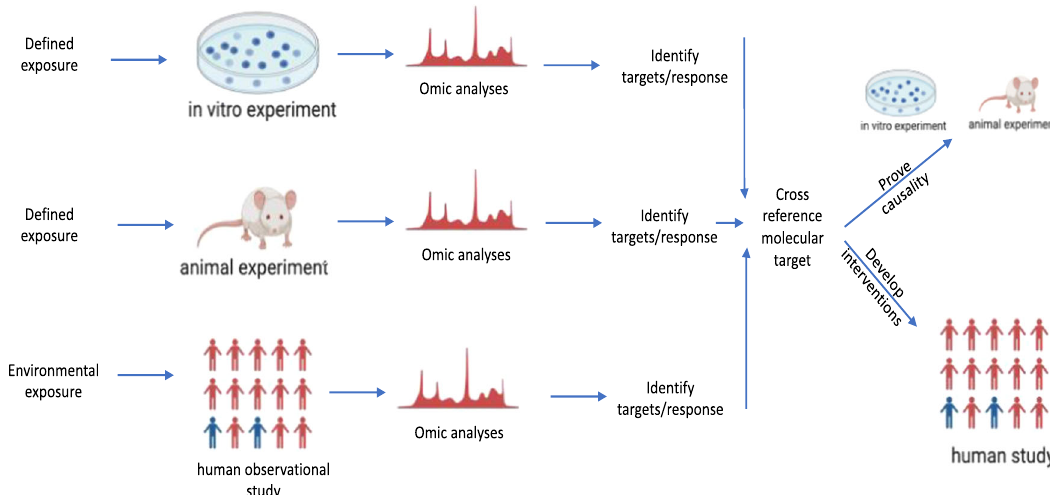
Fig. 2 | Translational framework of environmental epigenomics and precision environmental health. While human cohort studies can examine associations betweenenvironmentalexposuresandhealthoutcomes,onlysurrogatetissuesare availabletoassessmolecularmechanismsinvolvedincomplexbiologicalfunctions. Animal models can provide additional mechanistic insight by allowing for multi-